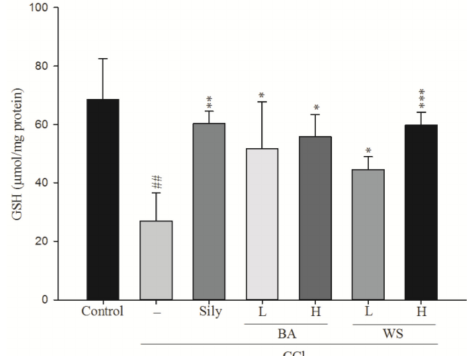
Figure 5. Effect of different fractions of black garlic and silymarin on hepatic GSH content in mice treated with CCl 4 . Each value represents as mean ± S.E.M. ( n = 10). ## p < 0.01 as compared with the control group. * p < 0.05, ** p < 0.01, *** p < 0.001 as compared with the CCl 4 group (one-way ANOVA